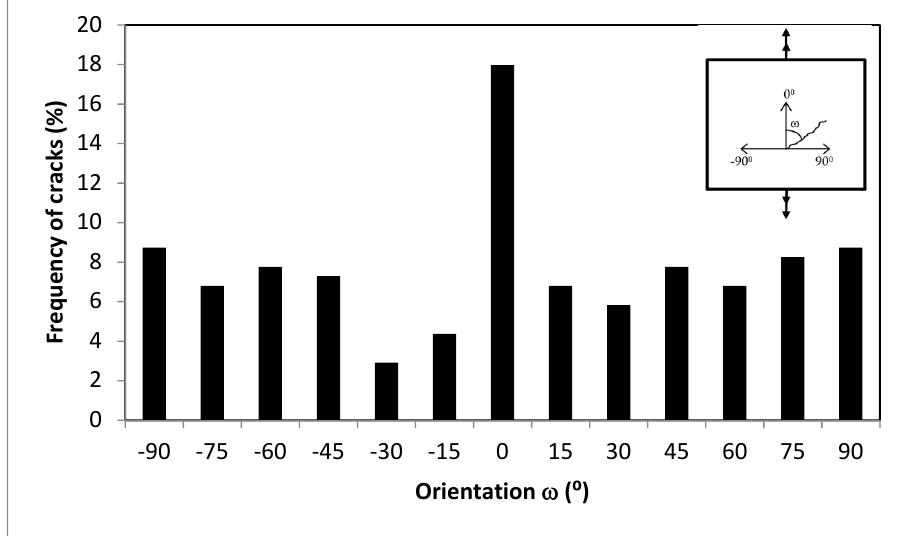
Figure 18. The microcracks and the orientation of the specimen under torsion loading.